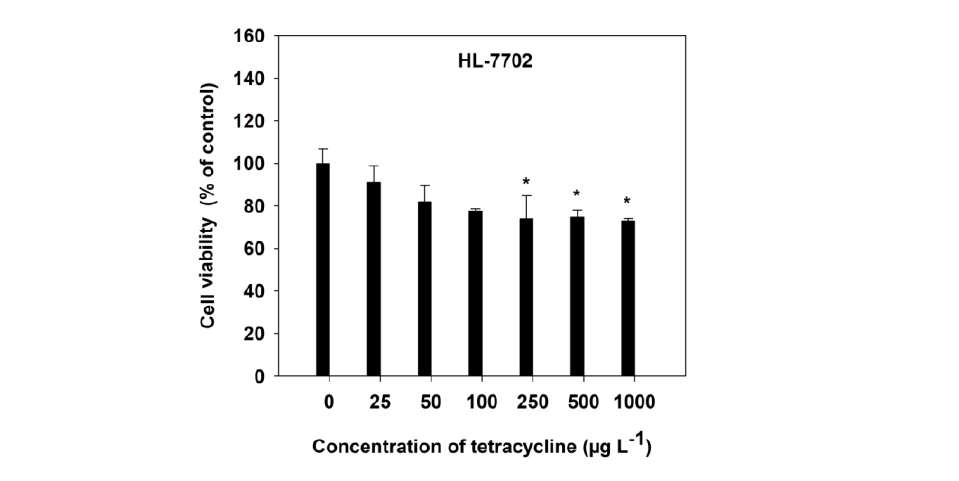
Figure 1. Effect of TC on cell viability in HL-7702 cells after 4-h incubation. Data are given as mean ± S.E. ( n = 6); “*” indicate significant ( p < 0.05) differences between controls (0 µ g L − 1 ) and treatments.